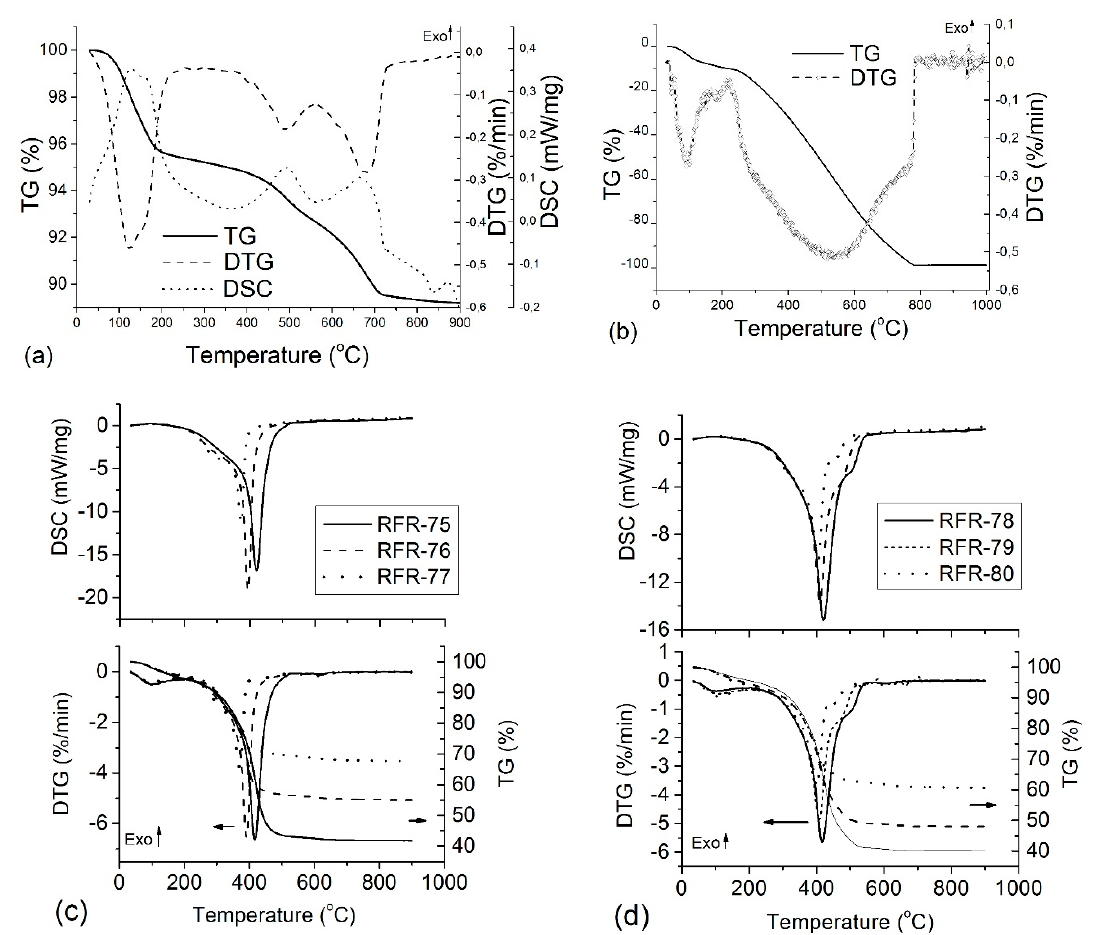
Figure 4. TG, DTG, and differential scanning calorimetry (DSC) curves of initial bentonite ( a ), control polymer ( b ) and organo-bentonite samples of first ( c ) and second ( d ) series.